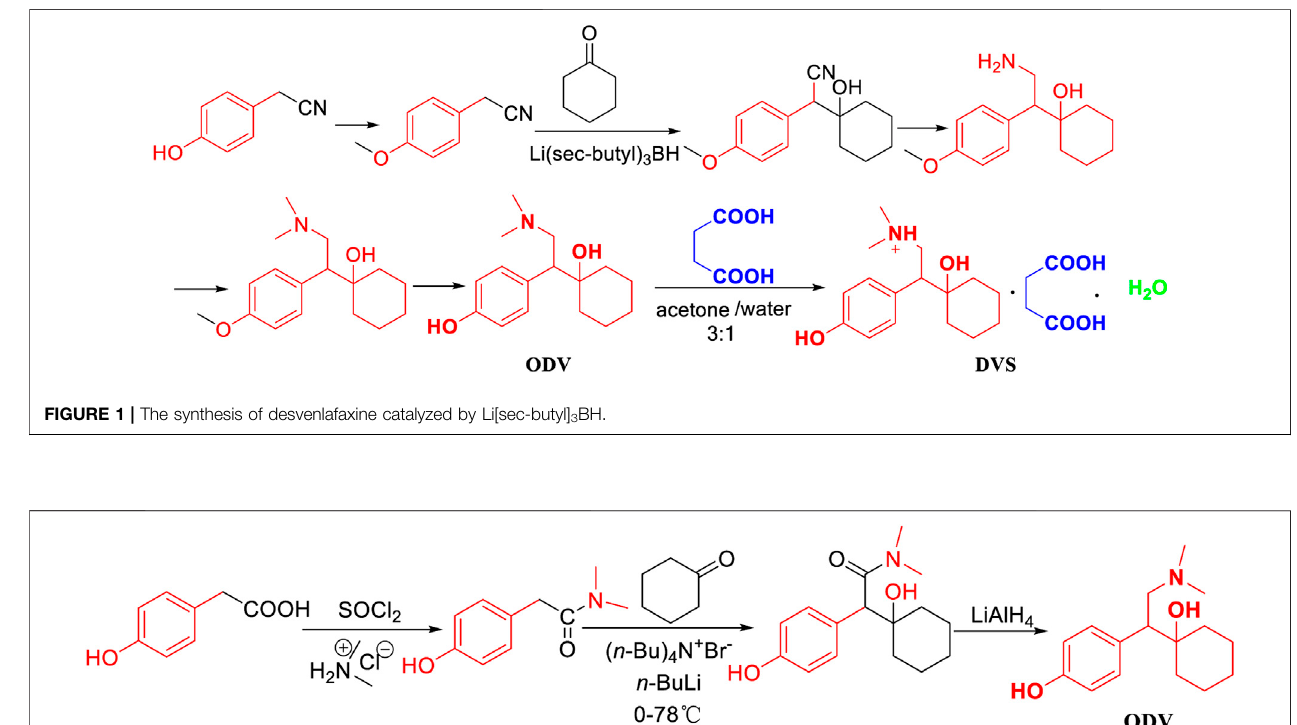
FIGURE 2 | The synthesis of desvenlafaxine from p-hydroxyphenylacetic acid.